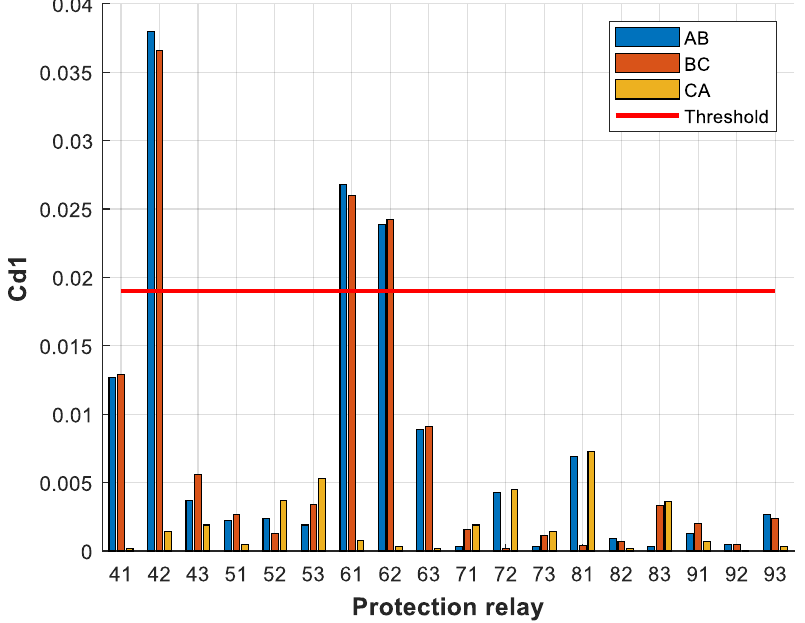
Figure 10. Differences in current Cd1-dB2 on the transmission line from bus 4 to bus 6.